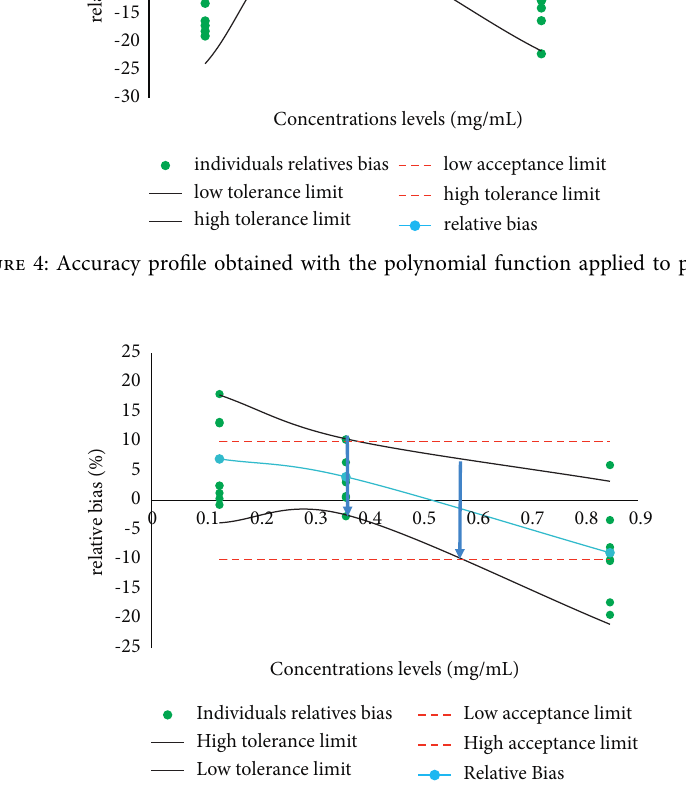
Figure 5: Accuracy profile obtained with the validation sample. Table 7: Precision data obtained with the polynomial function and the areas.